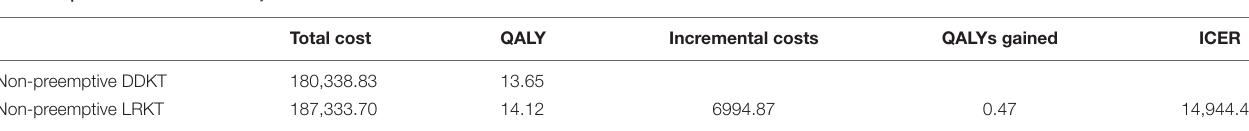
TABLE 5 | Results of